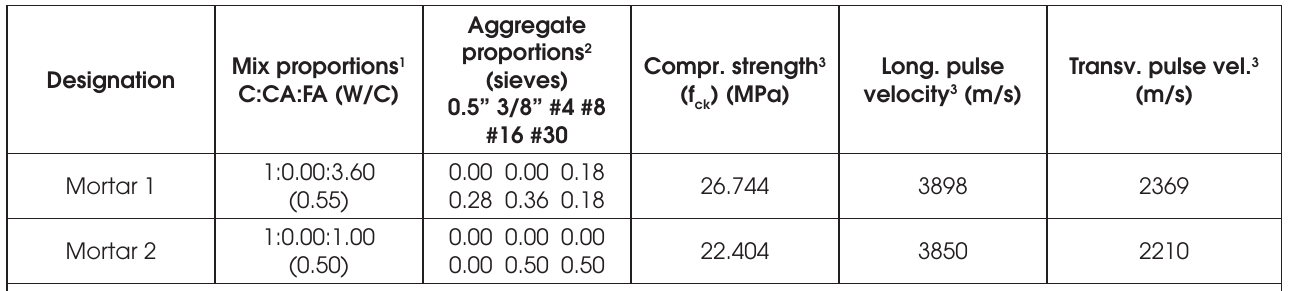
Figure 4.a show the variation of the modulus of elasticity for con- cretes with different aggregate types. Poisson’s ratio shows a slight increase with temperature up to approximately 50 o C (Figure 4.b). After that point Poisson’s ratio shows a fast decrease in its